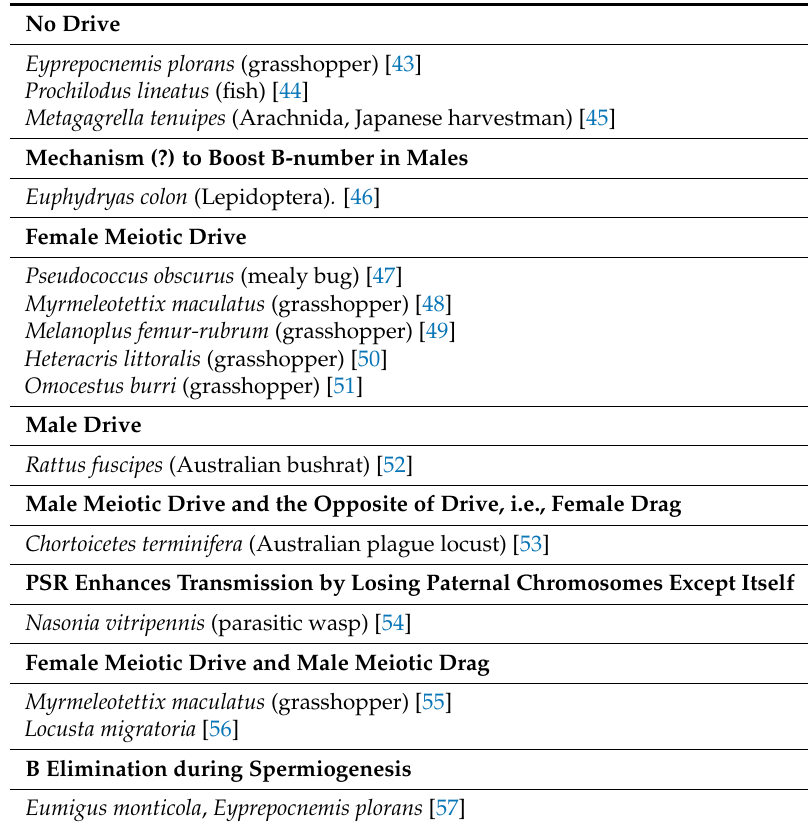
Table 3. Summary of various mechanisms of B-chromosome accumulation in